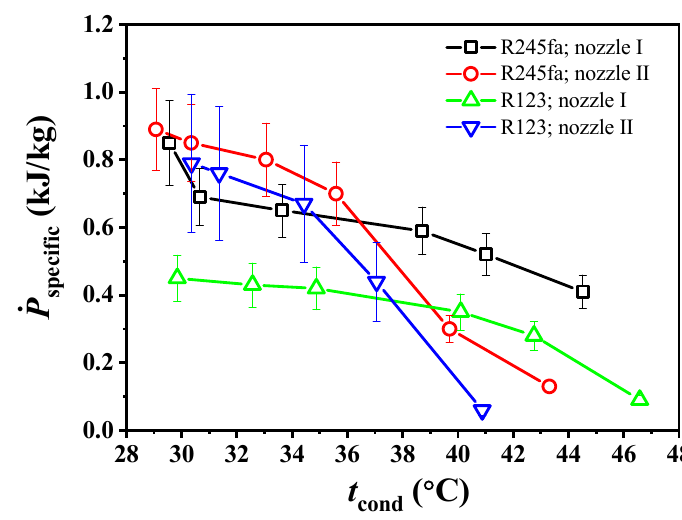
Figure 11. Variation of specific energy with condensing temperature.